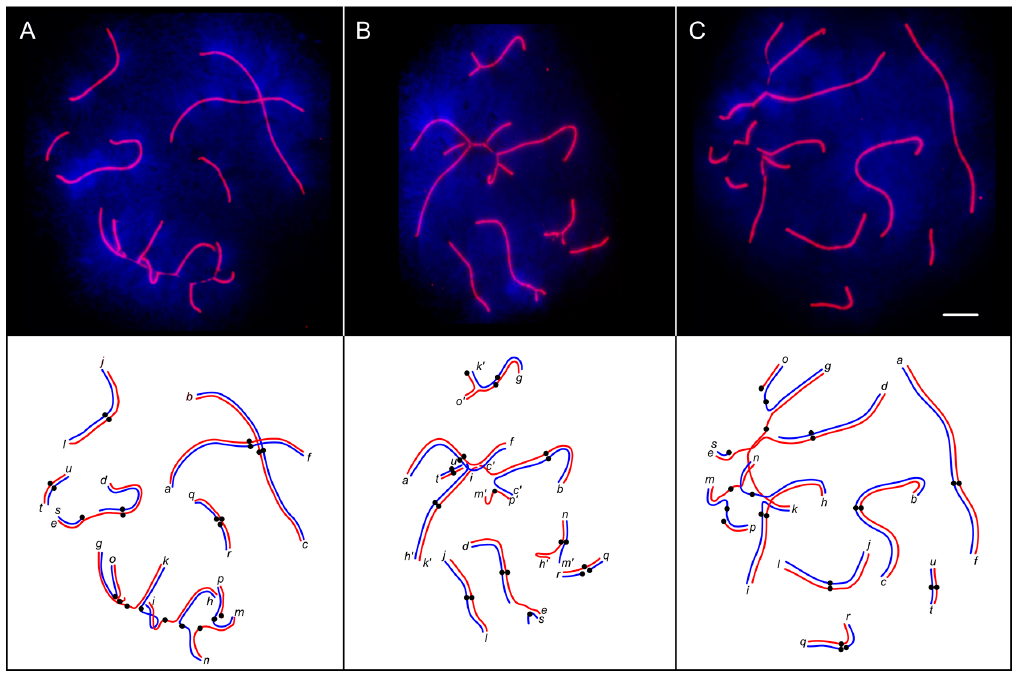
Figure 3. Fluorescent micrographs and interpretative diagrams of pachytene spermatocytes of a CVIII heterozygote after immunolocalisation of SYCP3 (red) and DAPI counterstaining (blue). Centromeres are marked with black circles on the diagrams. Letters indicate distal ends of the chromosome arms.